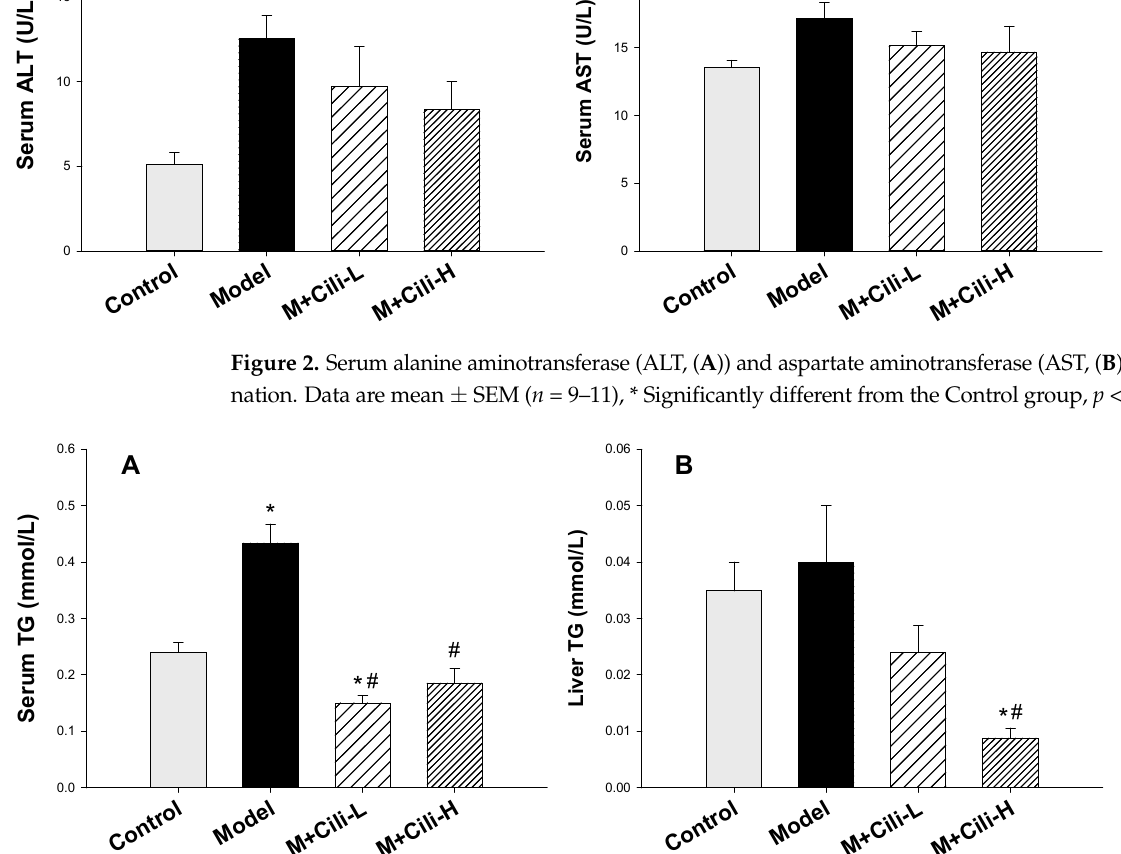
Figure 1. Animal body weight ( A ) and liver index ( B ). Mice were adapted to gradient alcohol in- crease from 1% to 5% in a Lieber-DeCarli liquid diet from Day 1 to Day 5, and Cili was gavaged at the 6th day (arrow) at 4 mL/kg (M+Cili-L) and 8 mL/kg (M+Cili-H) daily for 28 days (4 weeks). Livers were collected at the end of the experiment. Data are mean ± SEM ( n = 9), * Significantly different from the Control group, p < 0.05; # Significantly different from the Model group, p < 0.05. Alcohol feeding increased serum ALT (Figure 2A) and AST (Figure 2B) activities. Cili at both doses tended to decrease serum ALT, but was not significant, while it did not affect the AST activity compared to the Model group.